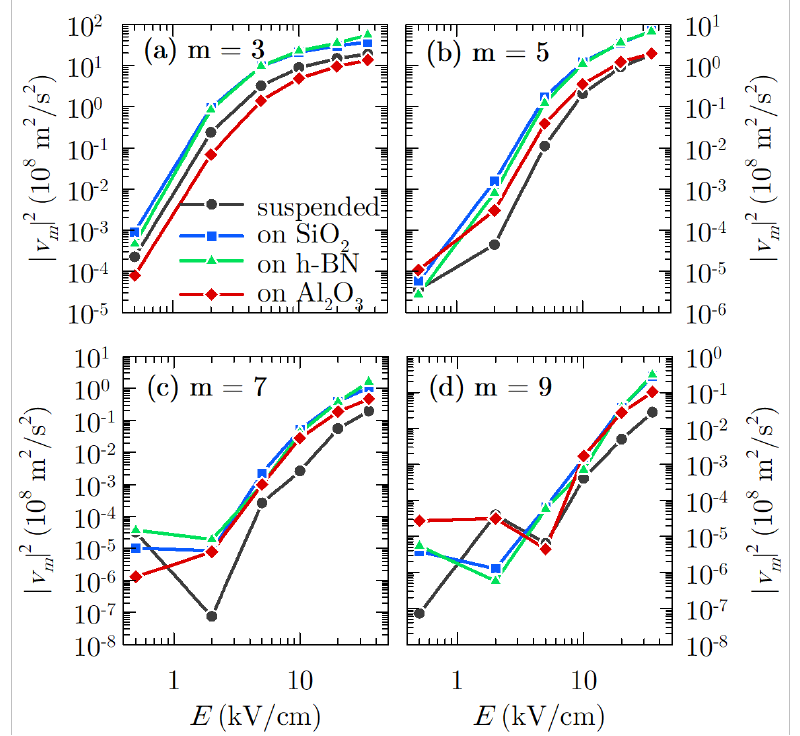
Figure 4. Intensity of the ( a ) third, ( b ) fifth, ( c ) seventh and ( d ) ninth harmonics of the excitation frequency f = 300 GHz as a function of the electric field for the four cases under